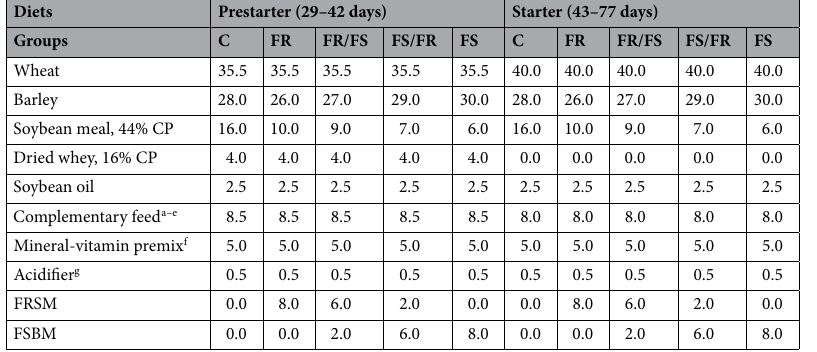
cases in relation to the total number of piglets in the group (diarrhoea incidence) and the average duration of diarrhoea in days were calculated. Apparent total tract digestibility (ATTD) of nutrients was measured in six barrows per group in metabolic cages in the period from 64 to 70 days of age (average body weight of piglets per group). At the end of the trial, the six piglets were slaughtered and ileal digesta was collected for determination of digestibility (AID). The slaughter was conducted in accordance with the technology currently employed in the meat industry. Following electrical stunning, the pigs were killed by bleeding, by severing the blood vessels of the throat. The contents of the ileum were collected for microbiological tests, and tissue samples from the gastrointesti- nal tract (ileum, caecum and colon) were collected for histological examination. The samples were fixed in 10% buffered formalin and stored at approx. − 4 °C. Determination of nutrient digestibility. About 0.3 kg of faeces was collected in the morning from six animals in each group. The faeces were weighed, and samples from 6 days were collected in a covered container with a few drops of sulphuric acid and frozen.